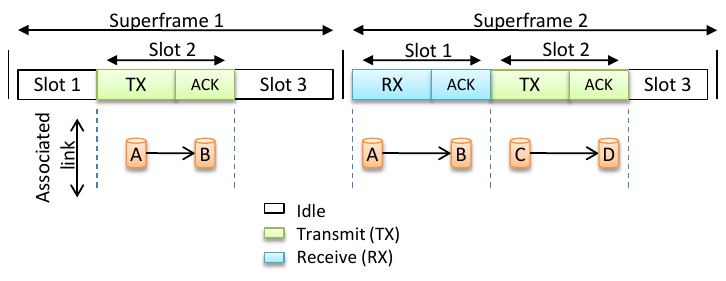
Figure 7. ISA100.11a superframes